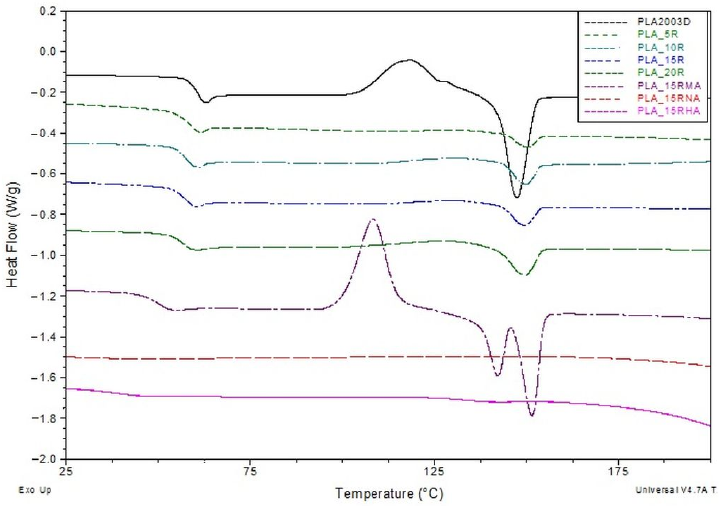
Figure 8. DSC curves (exo up) from the second heating for neat PLA and PLA plasticized with natural and modified castor oil.